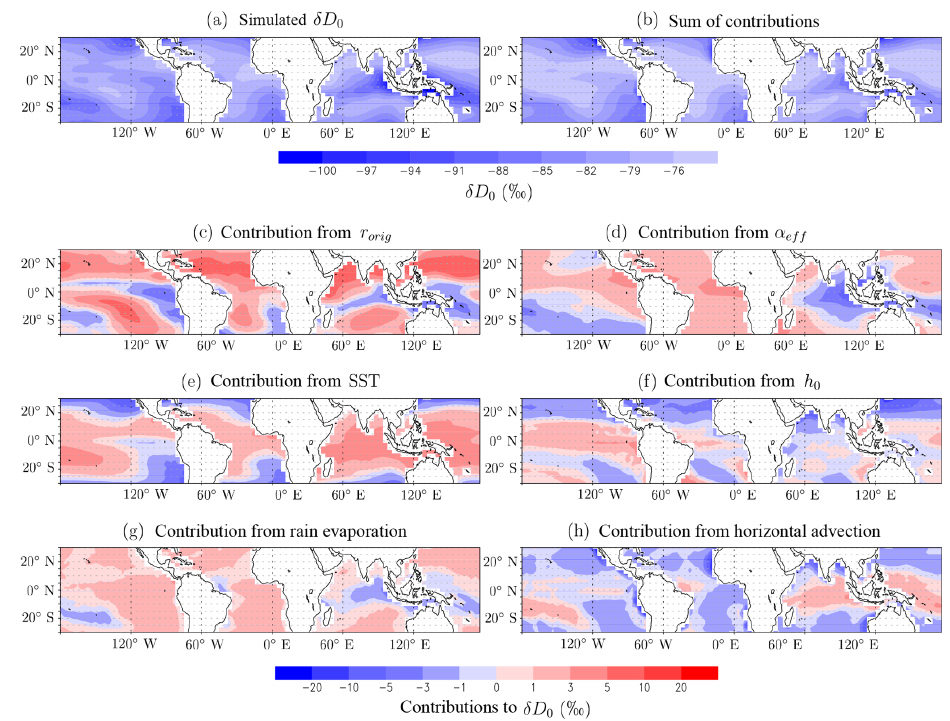
Figure 7. (a) Map of winter-mean δD 0 simulated by LMDZ. (b) Map of winter-mean δD 0 reconstructed as the sum of the four contributions. Tropical-mean δD 0 was added to compare with (a) on the same color scale. (c) Map of the contribution of r orig on winter-mean δD 0 calculated from Eq. (9) (see Sect. 3.6). (d) Same as (b) but varies for α eff . (e) Same as (b) but for SST. (f) Same as (b) but for h 0 . Table 2. Decomposition of the spatial and seasonal variation in δD 0 into its six contributions: effect of r orig , α eff , SST, h 0 , rain evaporation, and horizontal advection. For each contribution, we show the correlation coefficient of the linear regression of the contribution as a function of δD 0 . The analysis is performed separately for ascending and subsiding regimes. All seasons and locations over tropical oceans (30 ◦ N–30 ◦ S, ocean fraction > 80%, surface evaporation > 0 . 5mmd − 1 ) are considered. The threshold for the correlation coefficient to be statistically significant at 99% is 0.15 or lower in all cases. We write correlation coefficient and slope values between brackets when they are not significant at 99%. Regime Ascending Subsiding Correlation Slope Correlation Slope coefficient